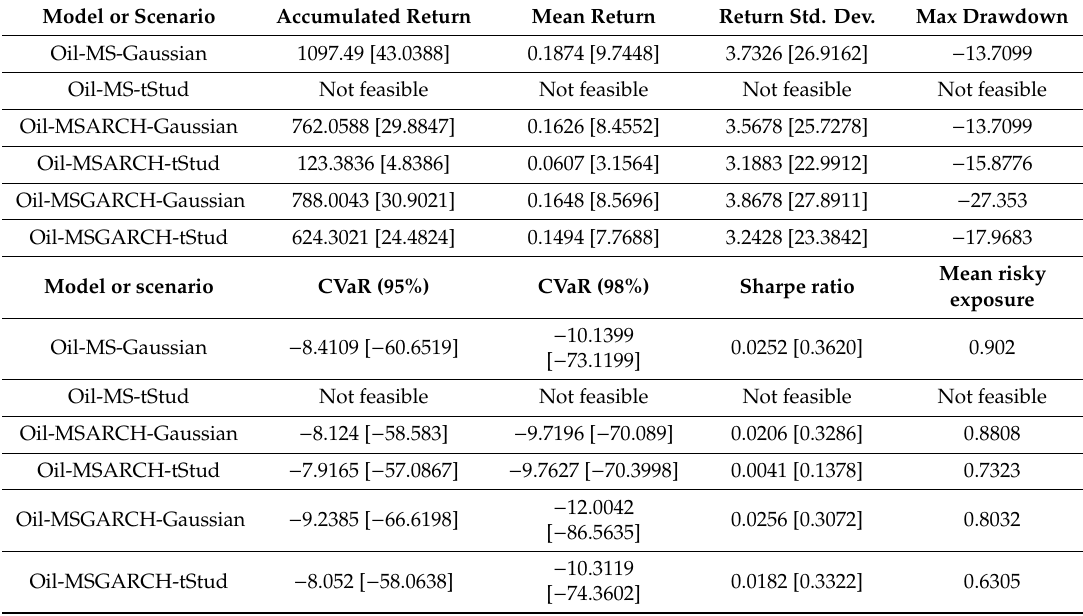
Table 5. Performance of the Markov-switching active investment strategy applied in the continuous one-month WTI oil future price